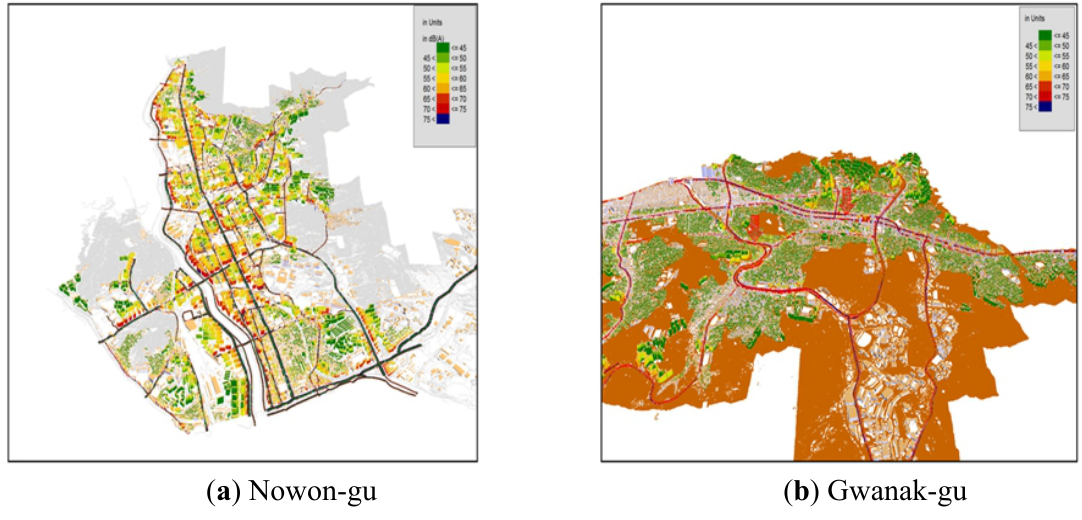
Figure 4. Façade noise maps of two districts (“whole” gu).